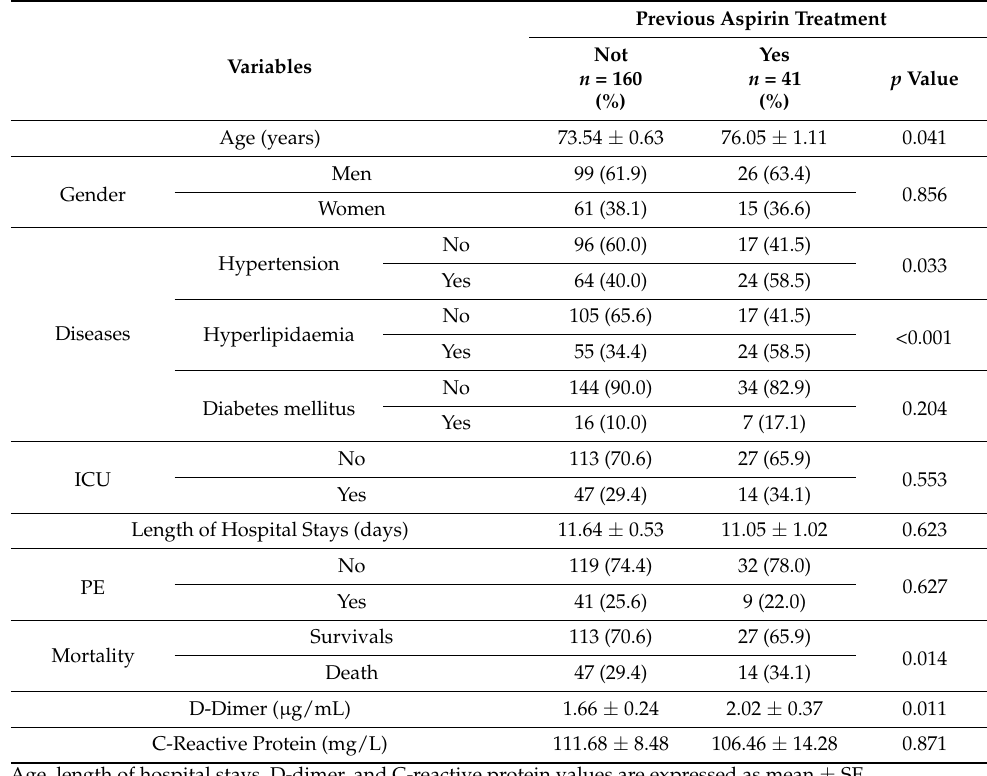
Previous Aspirin